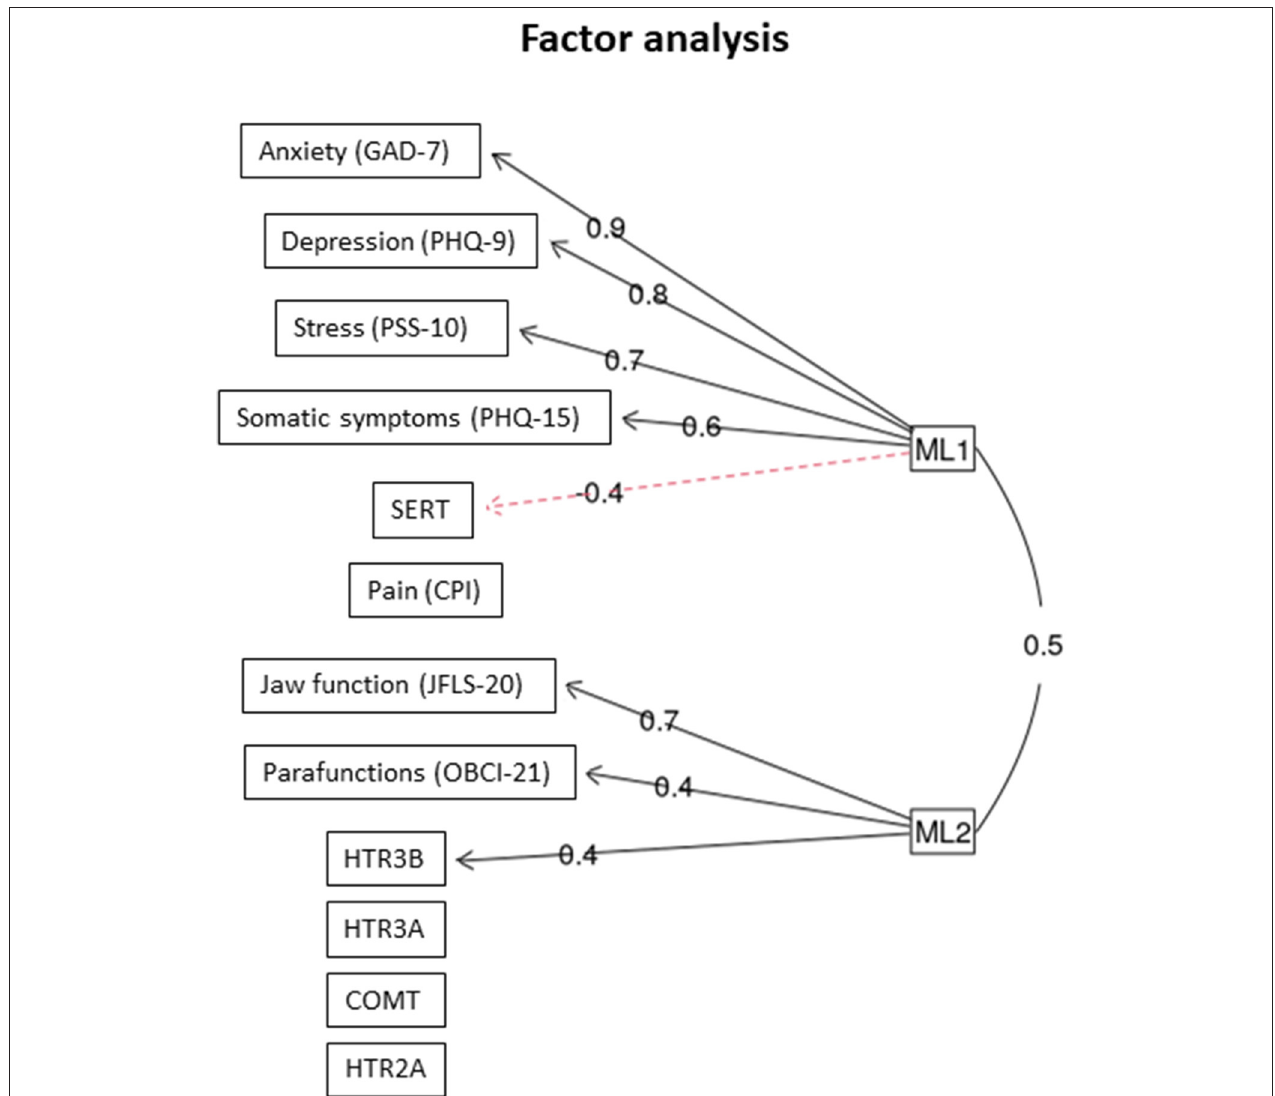
FIGURE 2 | Factor analysis. The two latent factors that were identified (ML1 and ML 2) and the outcome variables they co-variated with n = 117 individuals with TMD myalgia. The figures denote factor loading. GAD, general anxiety disorder; PHQ, patient history questionnaire; PSS, perceived stress scale; CPI, characteristic pain intensity; JFLS, jaw functional limitation scale; OBC, oral behavior